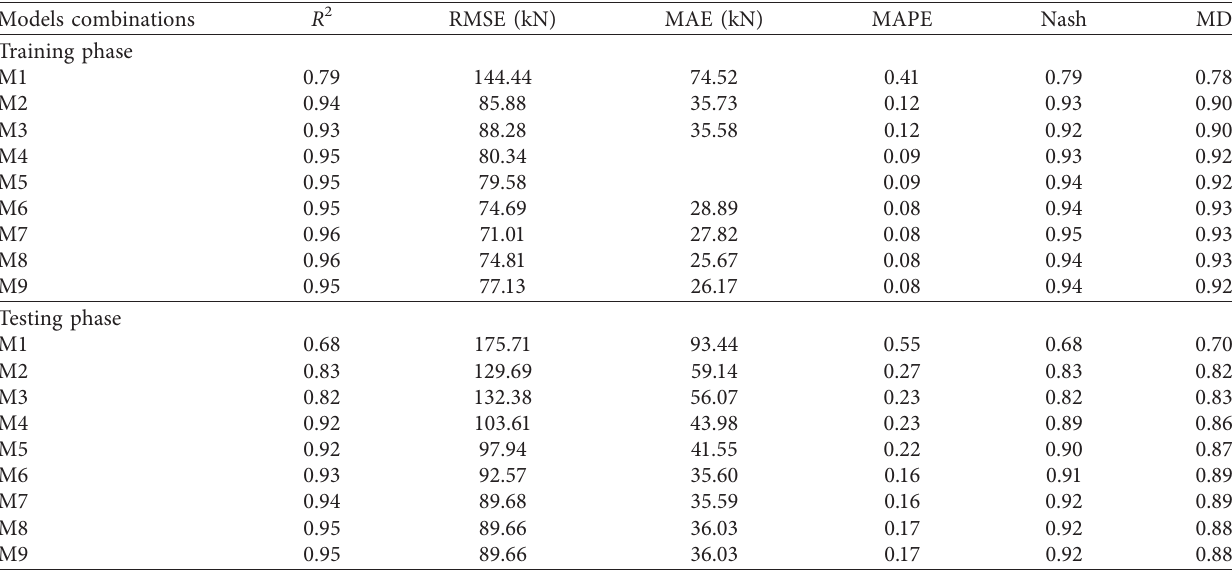
Table 2: The prediction results for the investigated nine input combinations over the training and testing phases for the proposed RF model. Models combinations